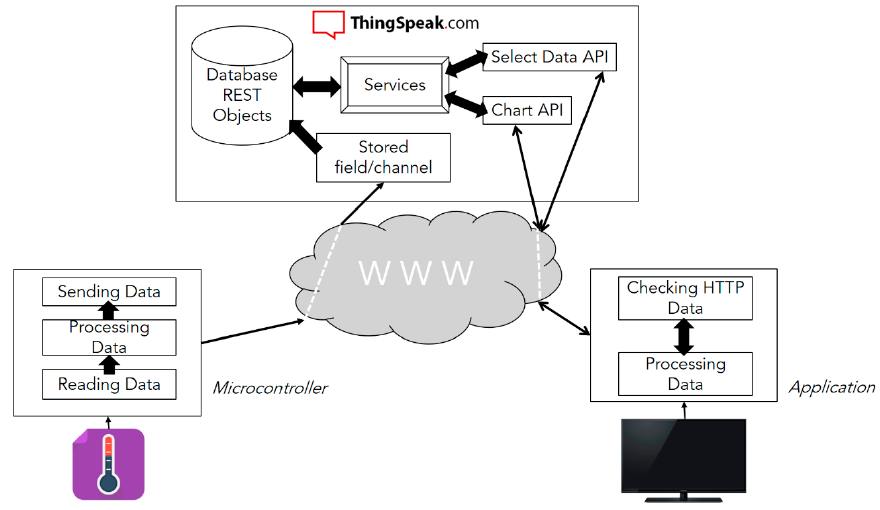
Figure 3. Interaction between SmartResidents actors.